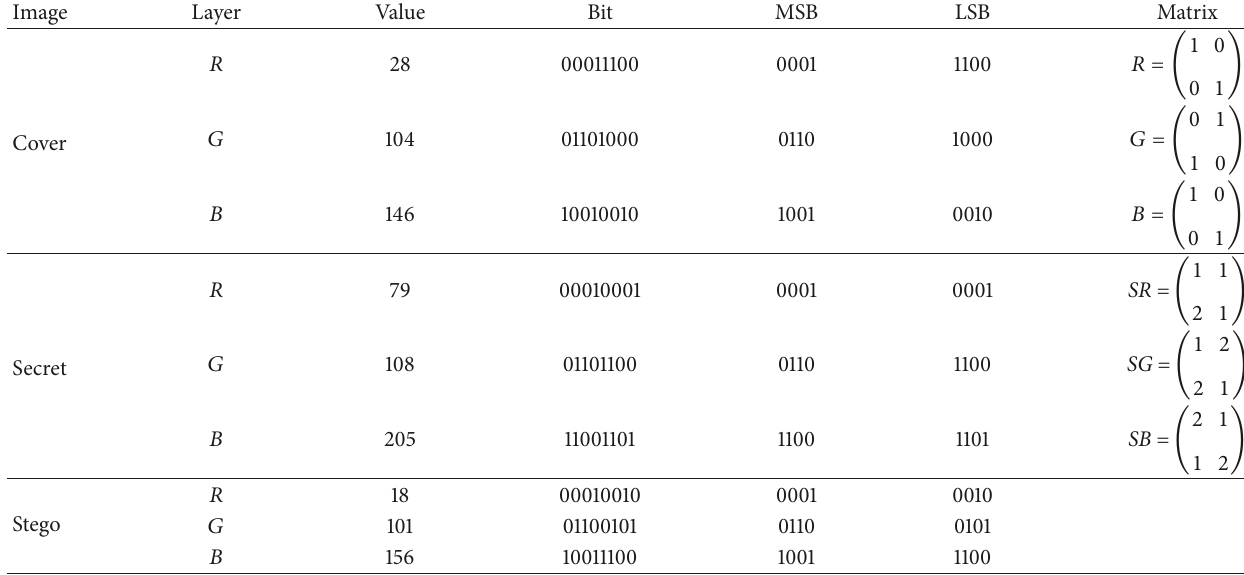
Figure 4: Flowchart to display the secret image of the stego image. Table 4: The